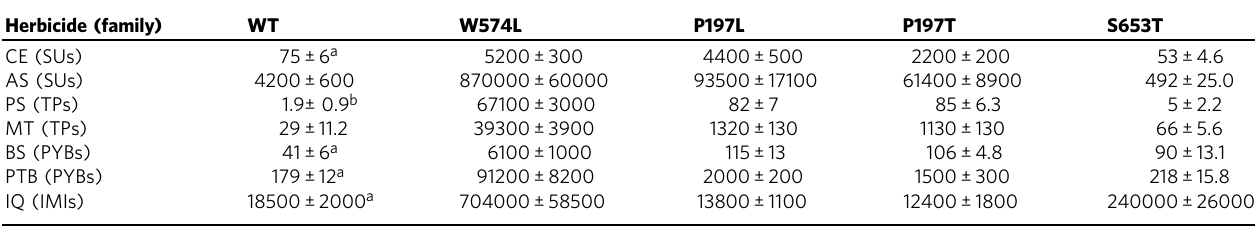
Table 1 K i (nM) values of the seven commercial herbicides for WT and mutant At AHASs. Herbicide